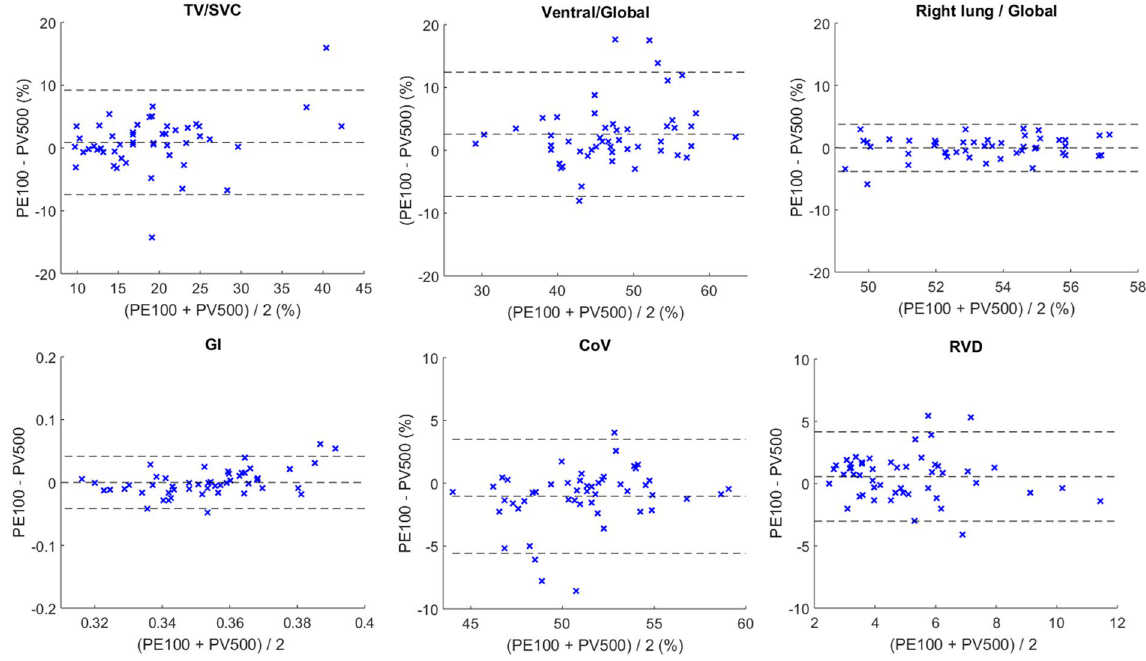
Figure 5. Bland–Altman plots compared the EIT-based measures calculated with PE100 (Pulmo EIT-100, FMMU) and the PV500 (PulmoVista500, Dräger). TV tidal impedance variation, SVC impedance variation during SVC maneuver, GI the global inhomogeneity index, CoV center of ventilation, RVD regional ventilation delay.